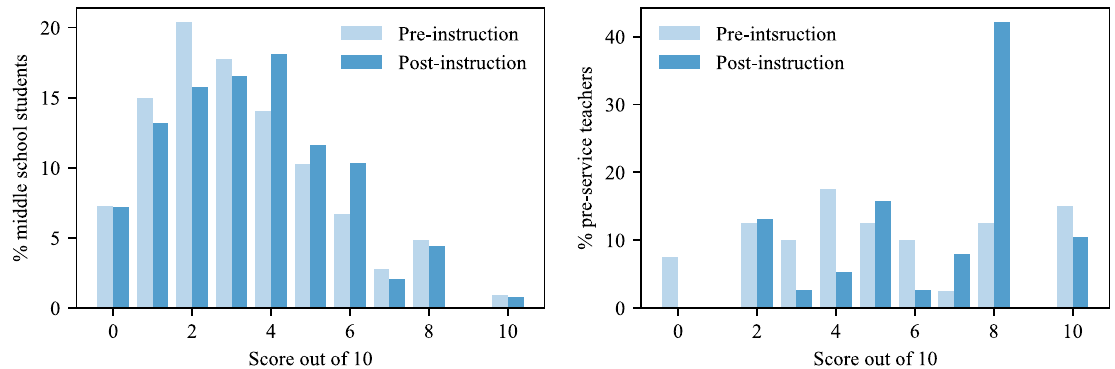
FIG. 4. Distribution of scores (number of items ranked correctly) for the ranking task in Q7, for middle school students (left panel) and preservice teachers (right panel). The average score for the middle school students was 35.3% preinstruction and 37.3% postinstruction; the average score for the preservice teachers was 52.8% preinstruction, and 64.8%